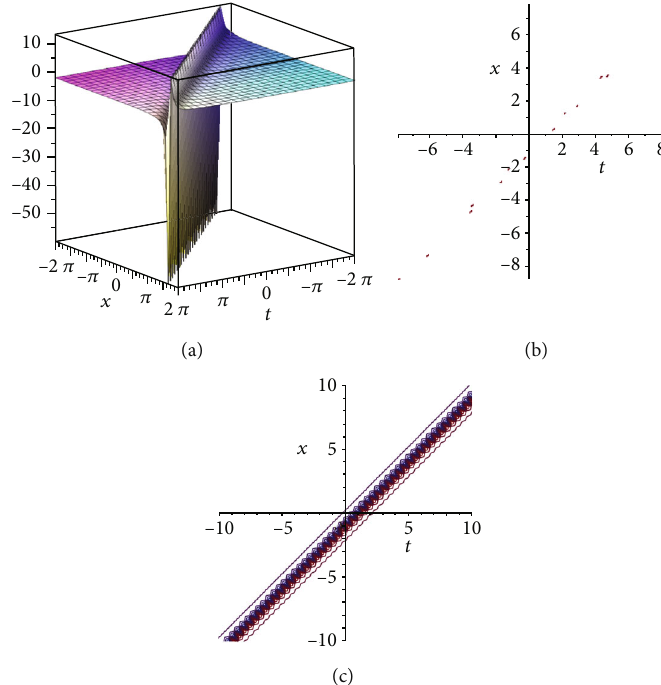
ð ξ Þ . Figure 5: The 3D, 2D, and contour images of Φ 335 Figure 5: The 3D, 2D, and contour images of Φ 335 ð ξ Þ by The all above wave pro fi les solutions of HFSCE keep their velocities, shapes, and amplitudes invariant during considering the values β 1 = 1 , β 2 = 4 , β 3 = 3 , β 4 = 2 , y = 1 , the appropriate value of some speci fi c parameters. In and q = 1 ; the graphs demonstrate the interactions between Figures 1, 3,and 4(a), we can see M-shaped waves train. In one soliton with kink waves of Φ 335 ð ξ Þ on the domain.